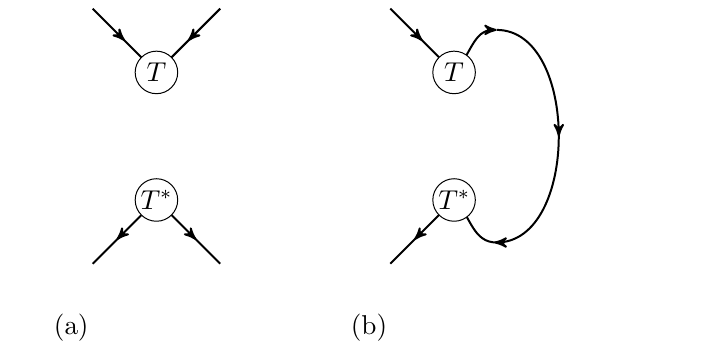
Figure 4. (a) Representation of the density matrix ρ AB shown in eq. (2.6) in the graphical notation. (b) Representation of the reduced density matrix ρ A in the graphical